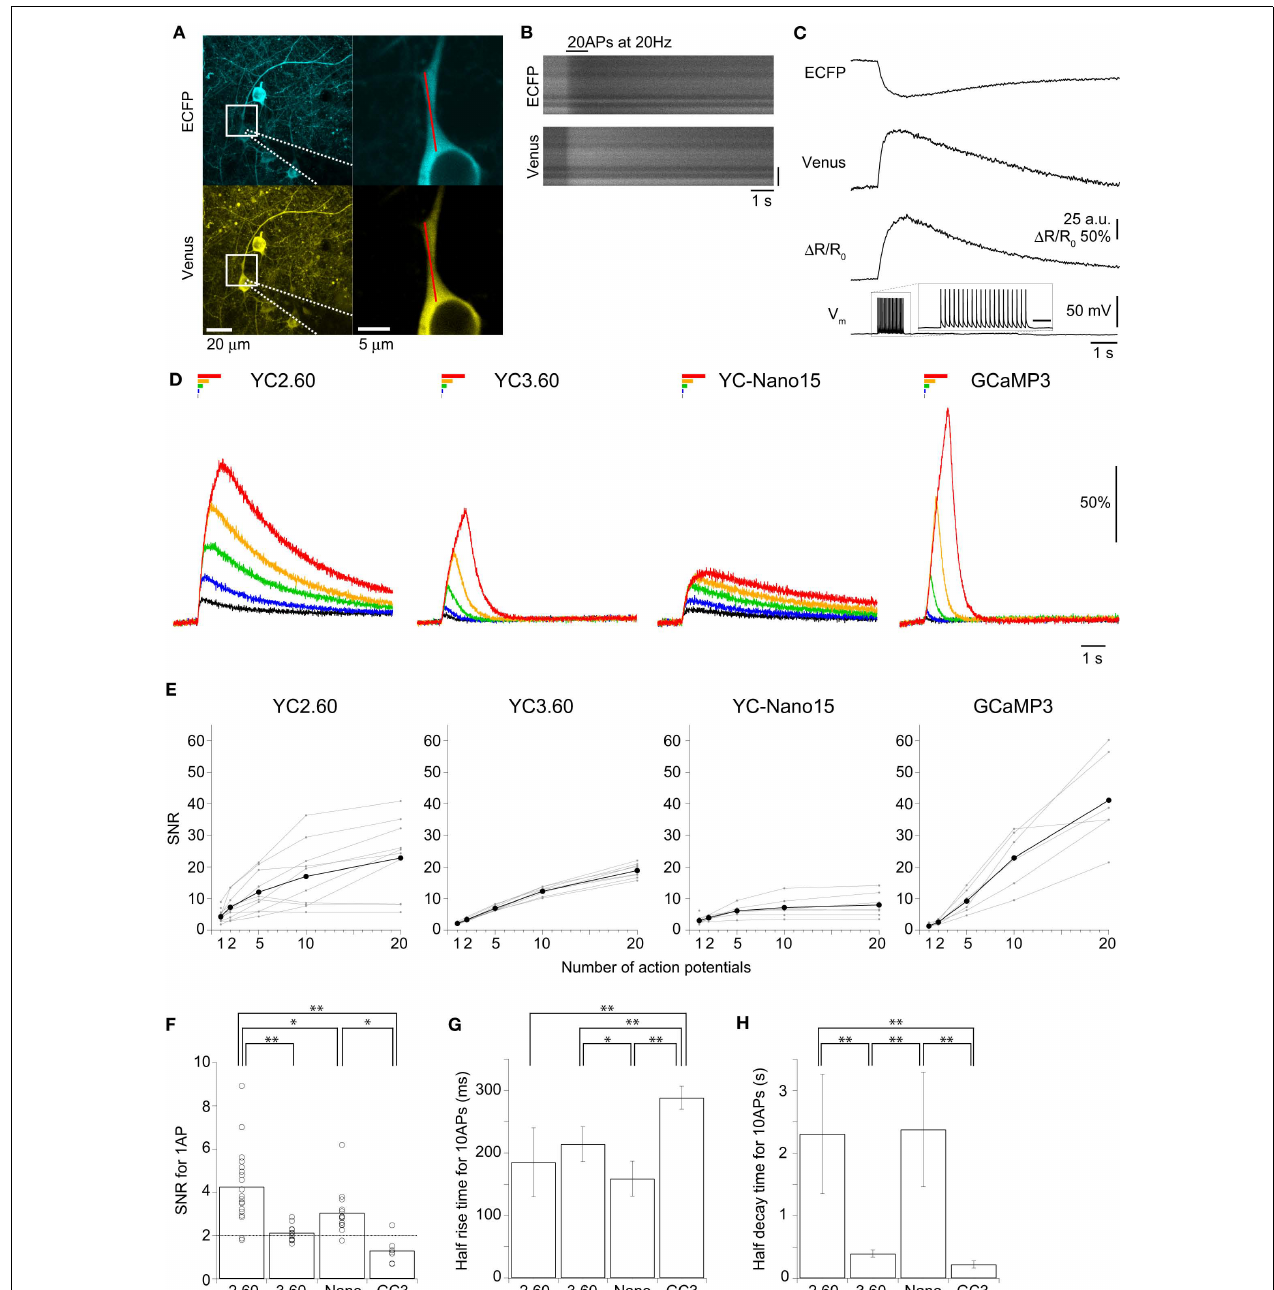
FIGURE 2 | Quantitative comparison of GECIs in cortical layer 2/3 pyramidal cells. (A) Maximum intensity projection images of an E14:P19 YC2.60-expressing pyramidal cells (left), and expanded single z -section images within the white boxes (right). A patch pipette is drawn with dotted lines. Line-scan imaging was performed along the proximal apical dendrite as indicated by the red line. (B) Line-scan images of aYC2.60-expressing pyramidal cell in response to 20 action potentials (APs) at 20Hz evoked during the period indicated.Vertical scale bar, 5 μ m. (C) Traces calculated from line-scan images in (B) were averaged across three trials and smoothed by 35ms moving window. Δ R/R 0 , FRET signal change; V m , membrane potential. The scale bar in V m inset, 200ms. (D) Δ R/R 0 (YC) or Δ F/F 0 (GC3) traces in response to 1 (black), 2 (blue), 5 (green), 10 (orange), and 20 (red) APs evoked